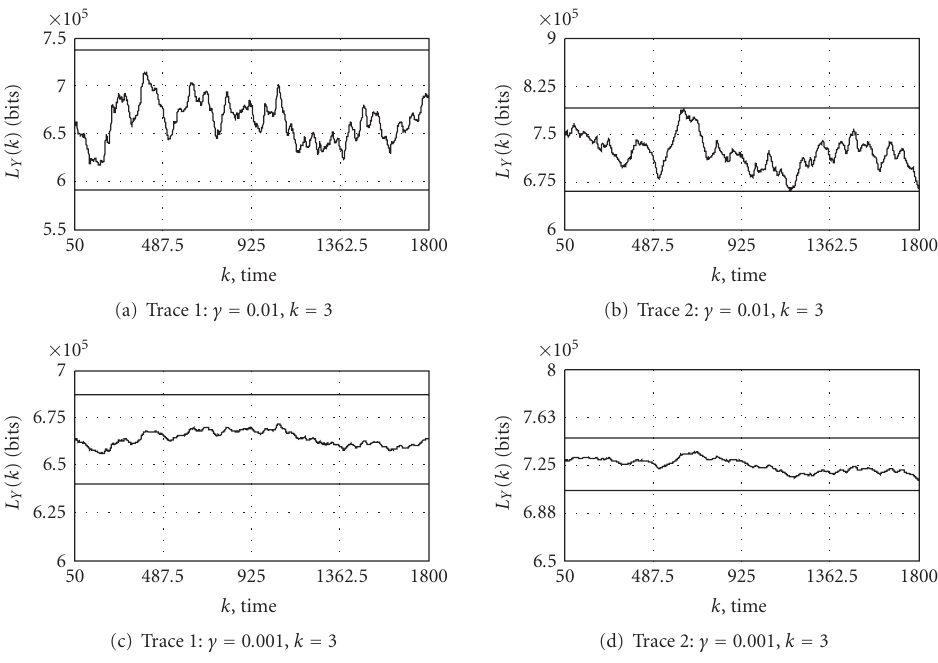
Figure 10: EWMA statistics for aggregated tra ffi c: fixed number of